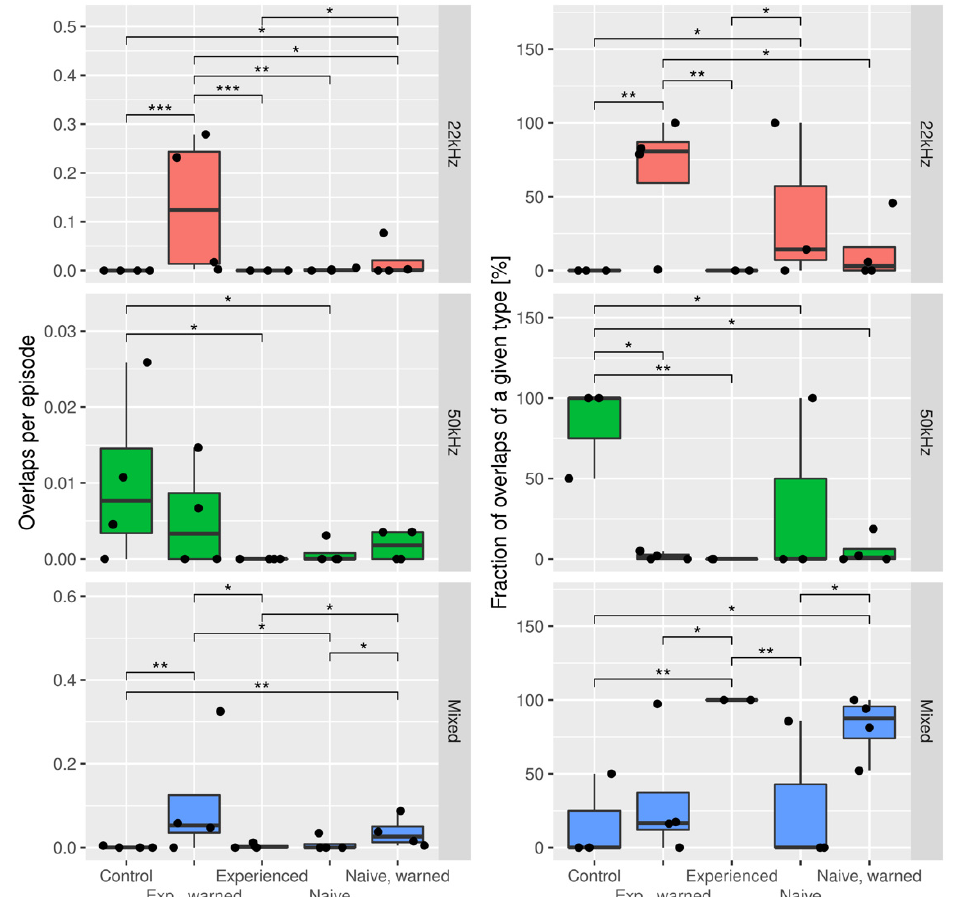
Figure 9. Fractions of temporal USV overlaps which belong to a certain class: 22 kHz—two 22 kHz calls overlapping, 50 kHz—two 50 kHz calls overlapping, mixed—22 and 50 kHz calls overlapping in different experimental groups. The left panels show the count normalized by the episode count, while the right panels show the count normalized by the total count of temporally overlapping USVs. Brackets mark significant differences identified by the Conover–Iman test. * p < 0.05; ** p < 0.01; *** p < 0.001.